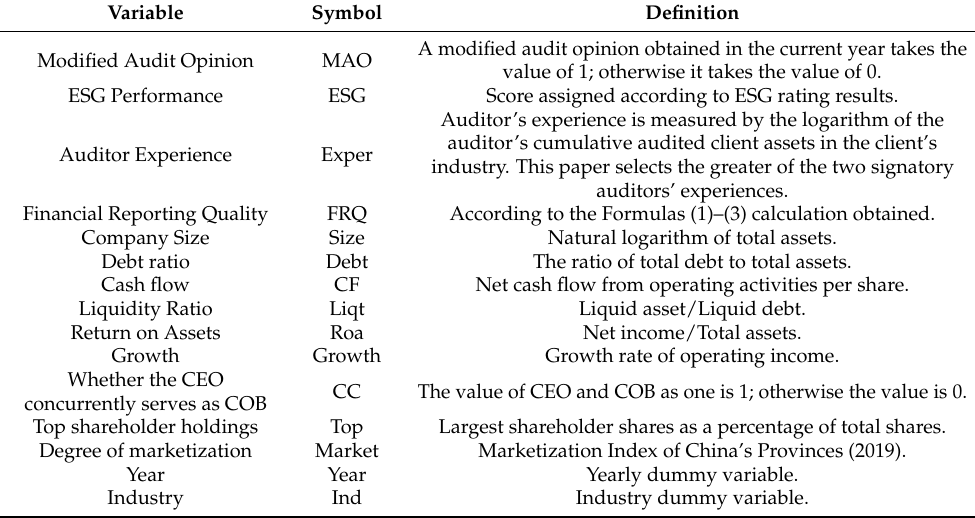
Table 1. Definitions of the